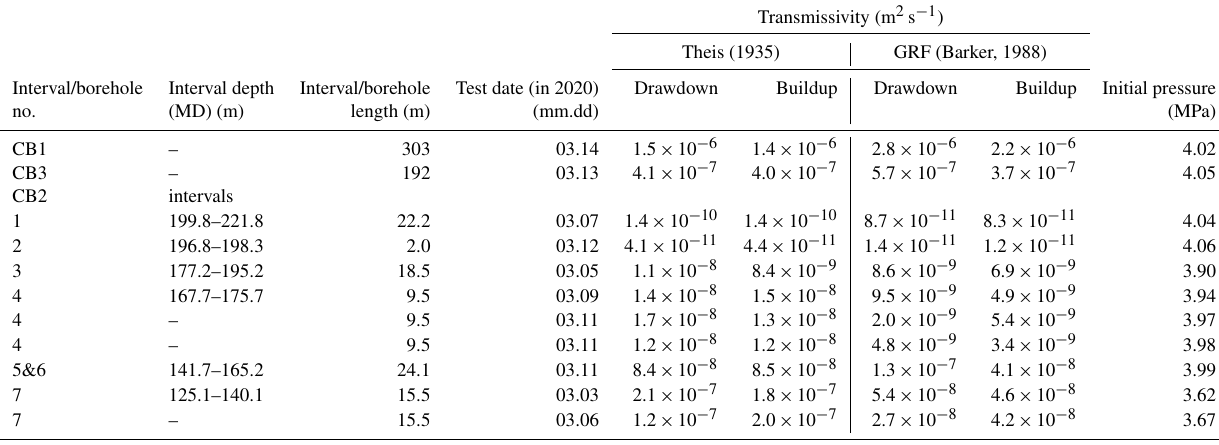
Table 2. Single-hole hydraulic test results.